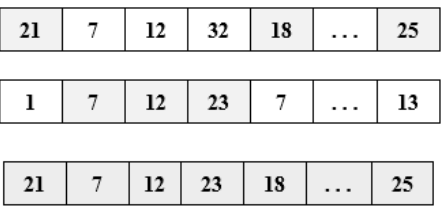
Fig. 9. Uniform crossover operator for a quantitative structure.